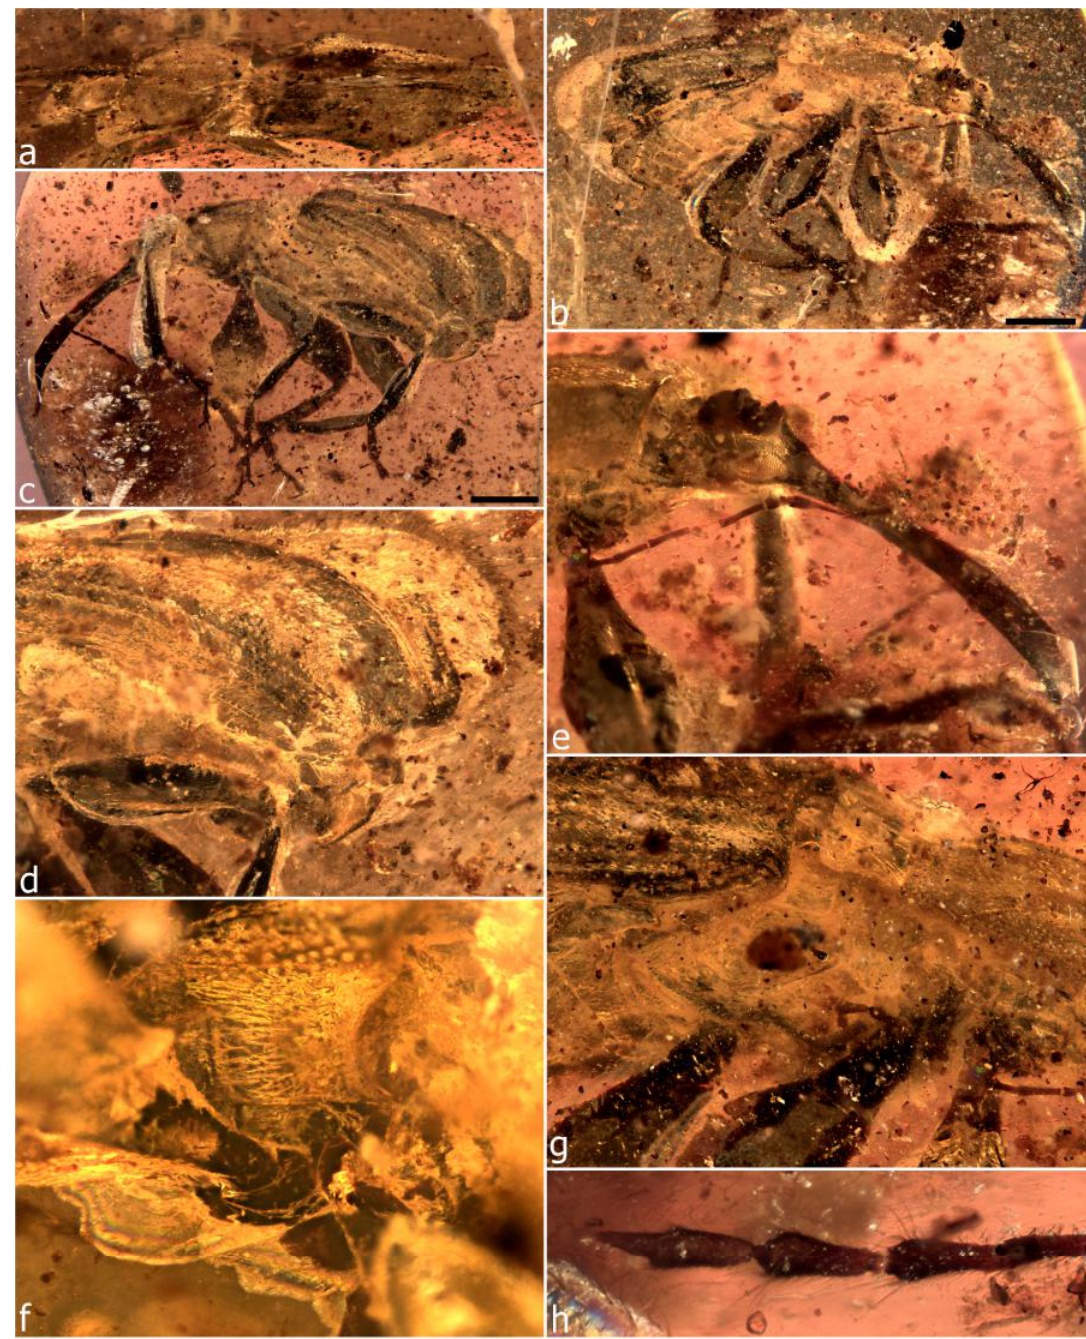
Figure 44. Echogomphus viridescens sp. n., holotype. Habitus, dorsal, showing effects of lateral distortion ( a ); habitus, right lateral ( b ); habitus, left lateral ( c ); apices of elytra and detail of pygidium, laterocaudad ( d ); head and antenna, right lateral ( e ); prothorax, showing notosternal suture ( f ); prothorax and elytral humerus, right lateral ( g ); antennal club ( h ). Scale bars: 1.0 mm (b,c).